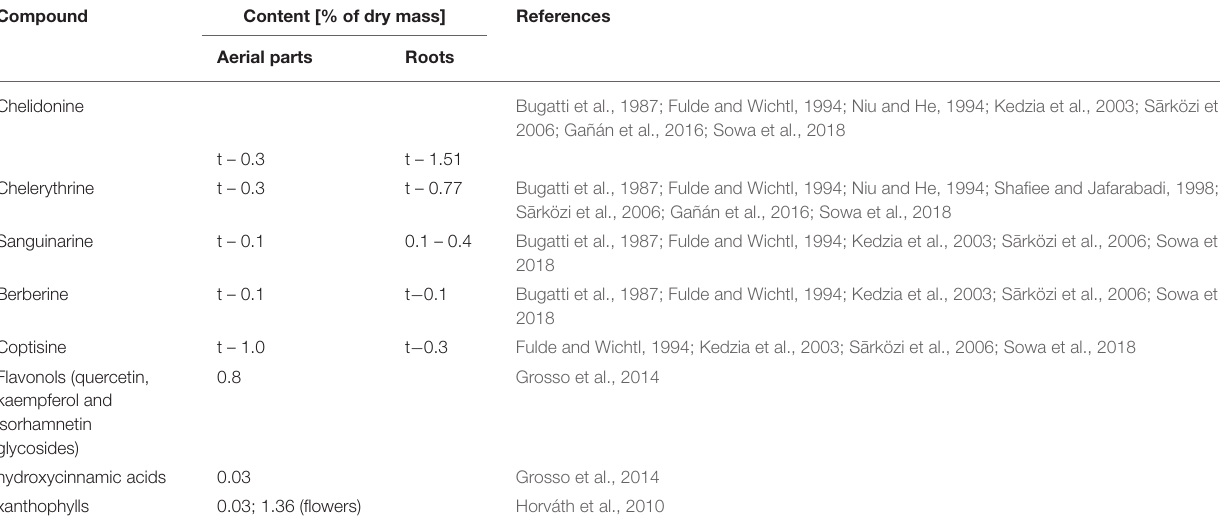
TABLE 1 | Content [%] of pharmacologically relevant constituents in aerial parts and roots of Chelidonium majus .